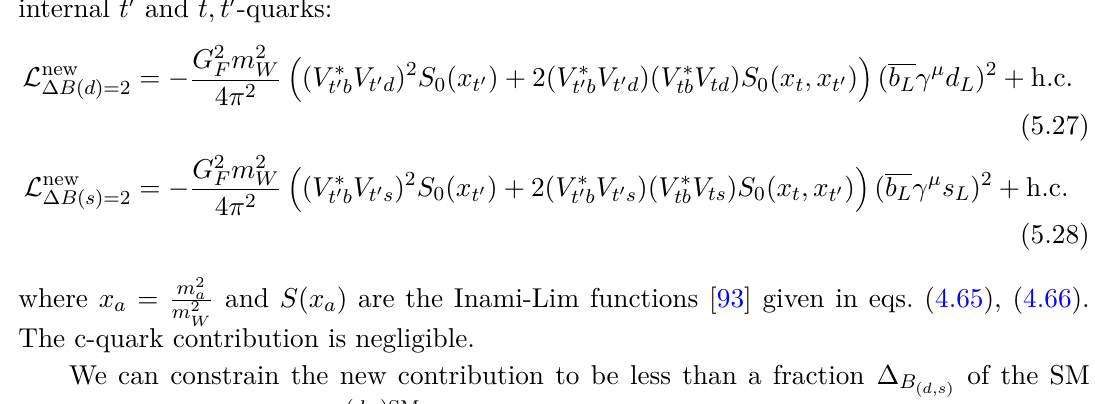
= 2 . 5 · 10 4 TeV, as defined ds, Im